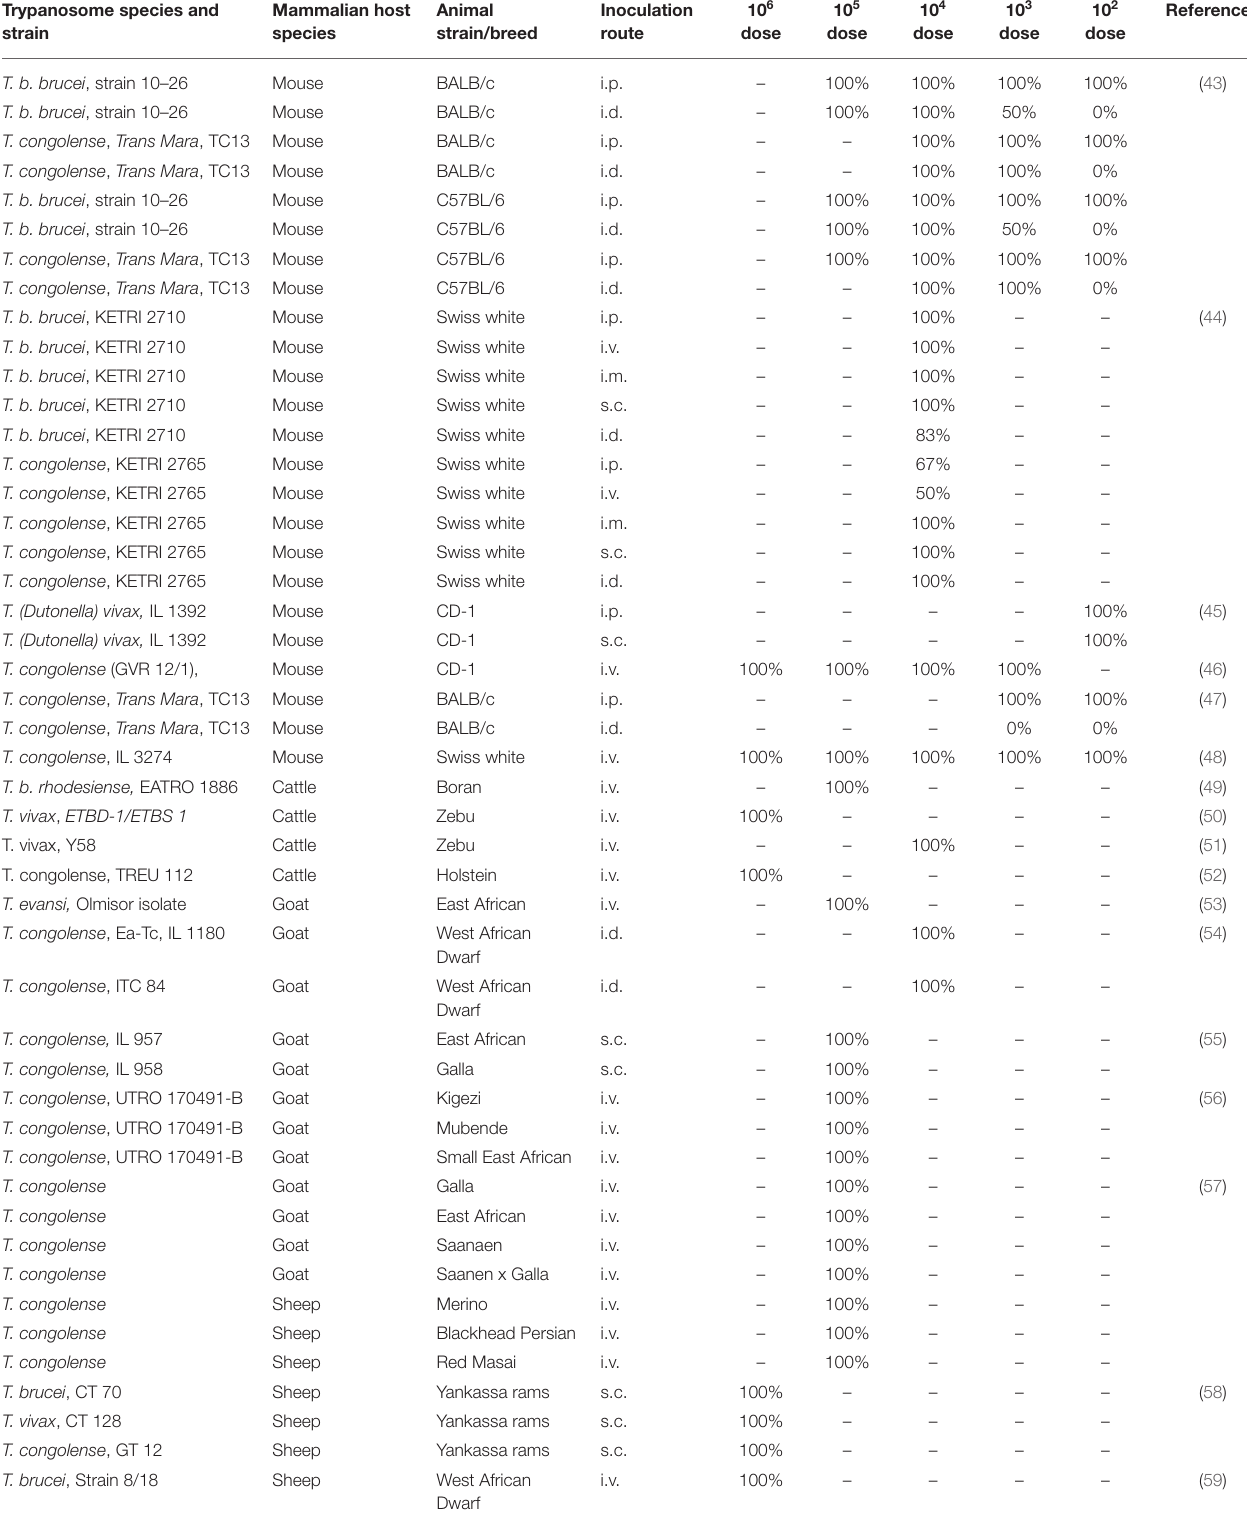
TABLE 1 | Susceptibility of various animal models to different trypanosome strains represented by the proportion of animals displaying a patent infection, depending on route and dose. Trypanosome species and